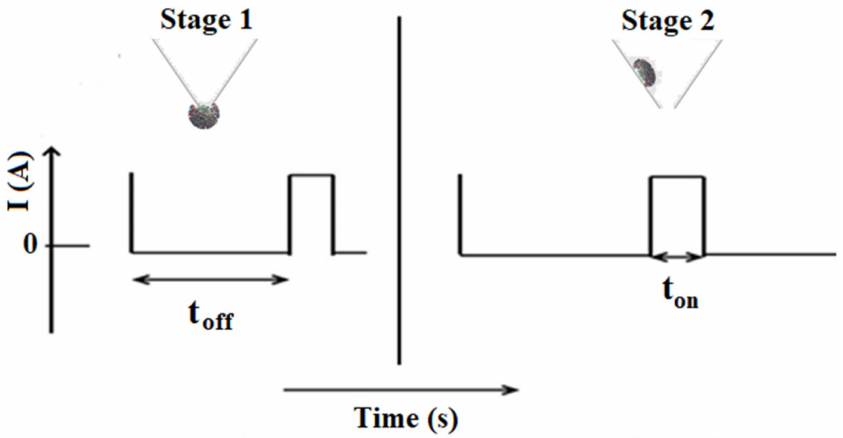
Figure 2. The model for current development in stochastic